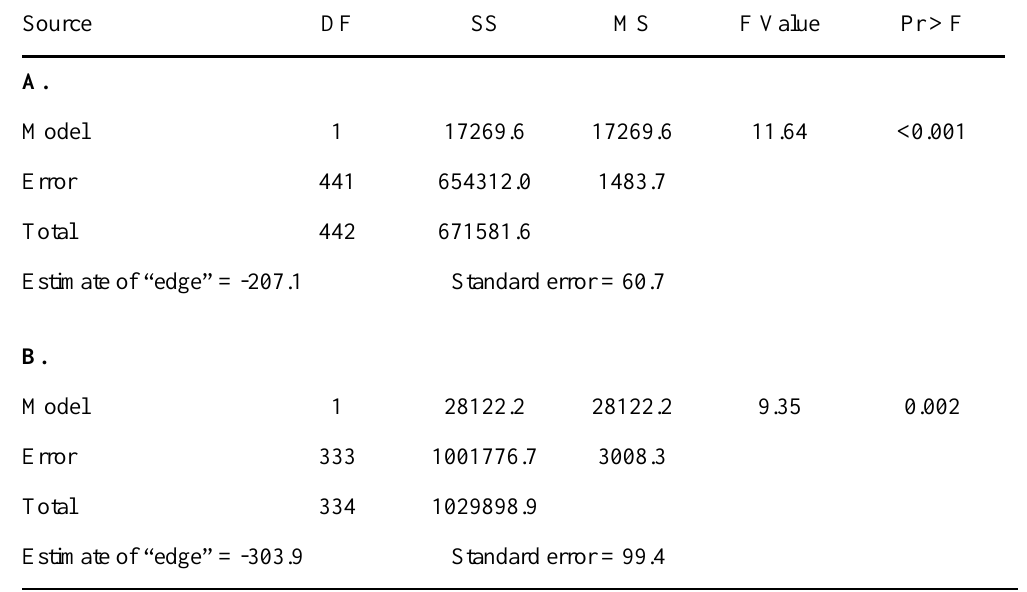
Table 1. ANOVA table from temporal analysis of the relationship between coefficient of variation and distance-to-edge of body-mass aggregations (A) and spatial analysis of the relationship between coefficient of variation and distance-to-edge of body-mass aggregations (B) of bird species of the Florida Everglades sub-ecoregion. Includes source, degrees of freedom (DF), Sum of squares (SS), Mean squares (MS), F values, associated probability values, as well as estimates of “distance-to-edge” and associated standard